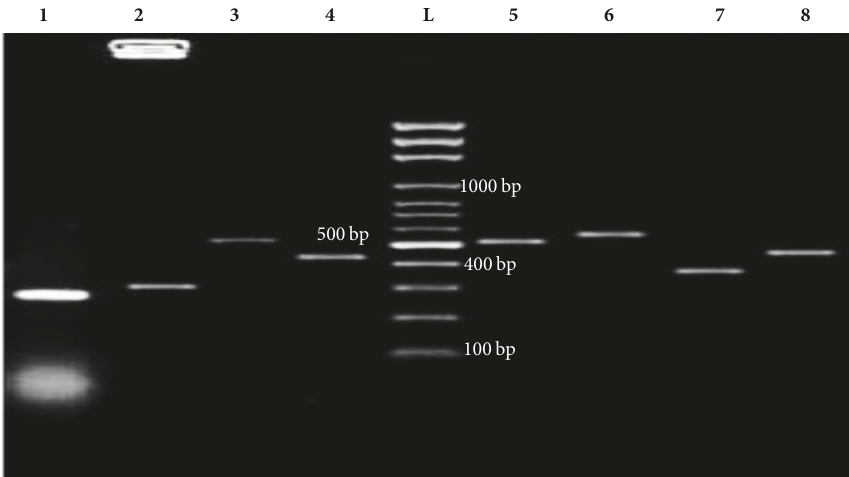
Figure 4: Representative PCR products of detected quinolone resistance genes. Lanes: (1) qnrB ; (2) qnrC ; (3) qnrD ; (4) qnrS ; (L) 100bp ladder; (5) acc(6 󸀠 )-Ib-cr ; (6) oqxA ; (7) oqxb ; (8)